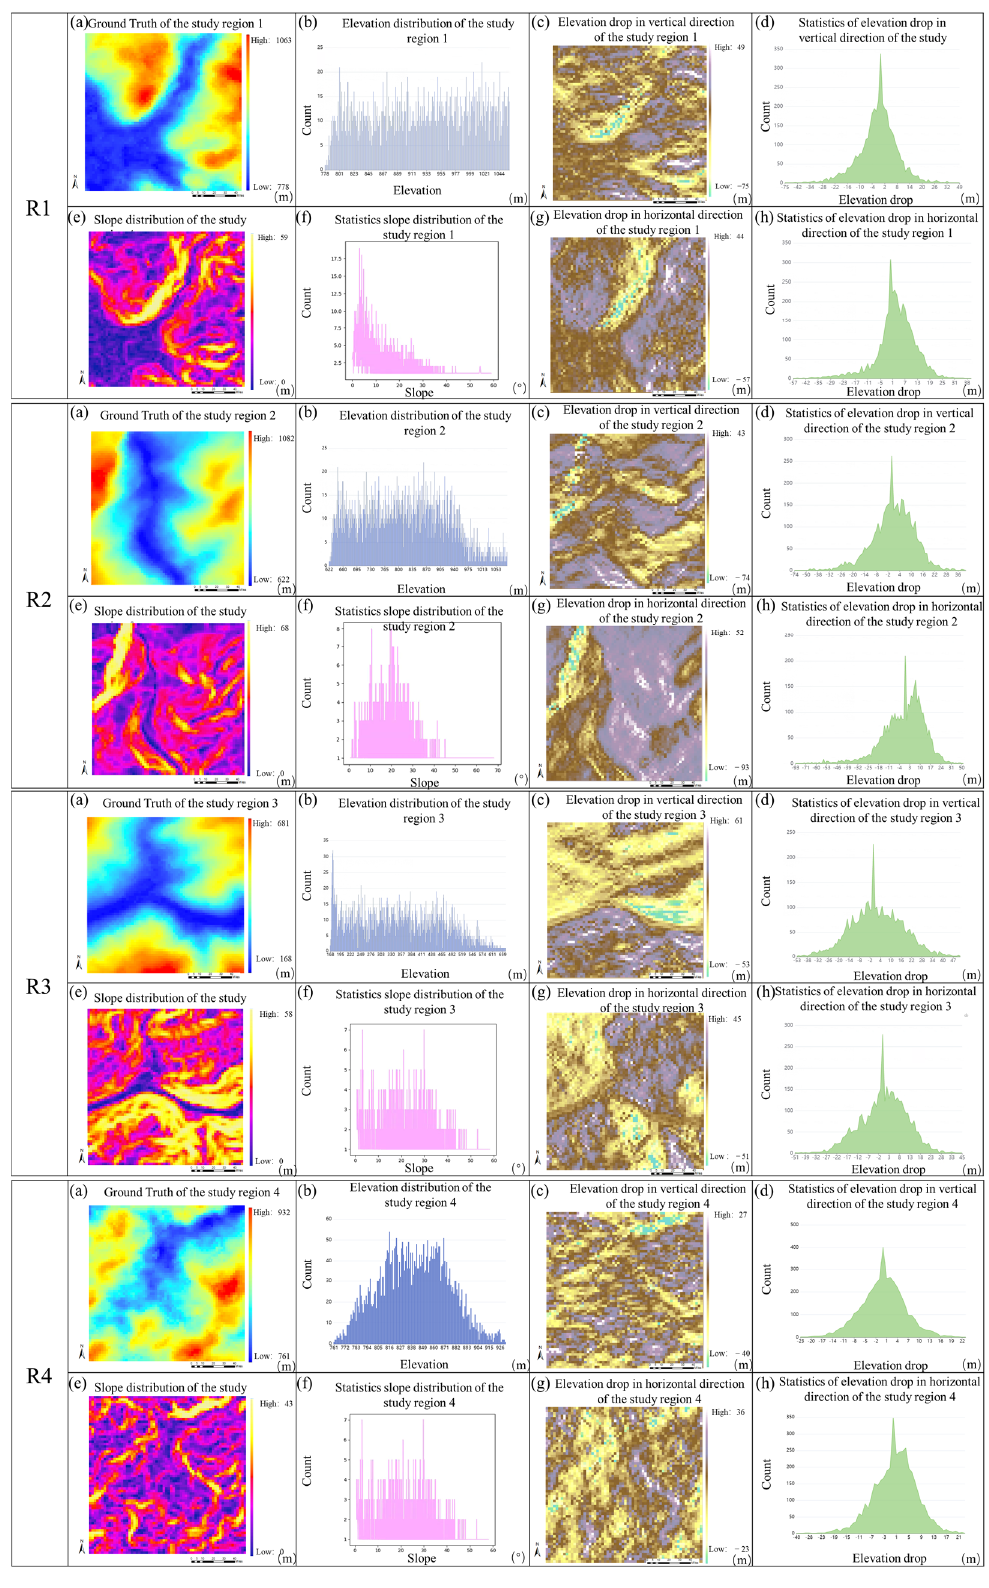
Figure 7. Detailed DEM parameters for each of the four test regions: ( a ) is the DEM of the study region, ( b ) is the elevation distribution of the study region, ( c ) is the elevation drop in the vertical direction of the study region, ( d ) is the statistics of elevation drop in the vertical direction of the study region, ( e ) is the slope distribution of the study region, ( f ) is the statistics slope distribution of the study region, ( g ) is the elevation drop in the horizontal direction of the study region, and ( h ) is